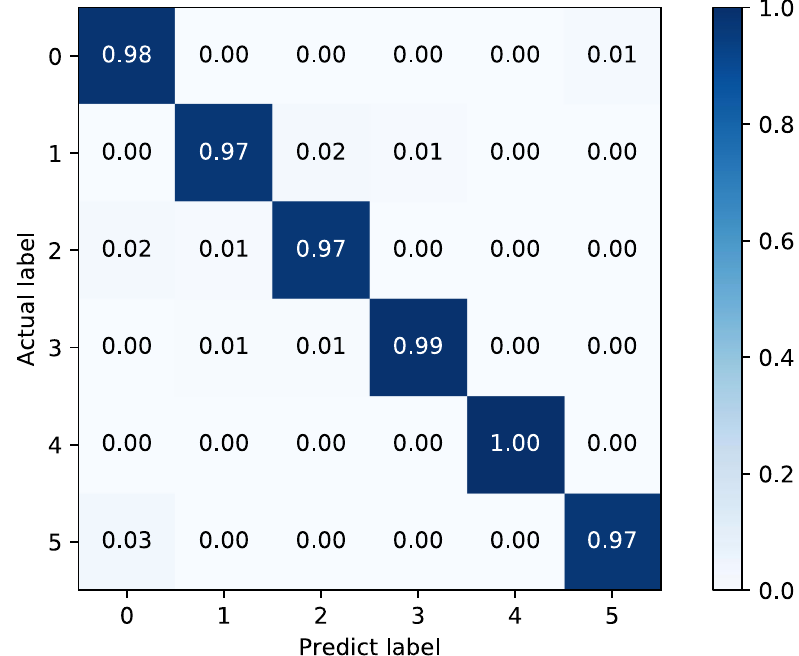
Figure 18. Confusion matrix of the fusion model.